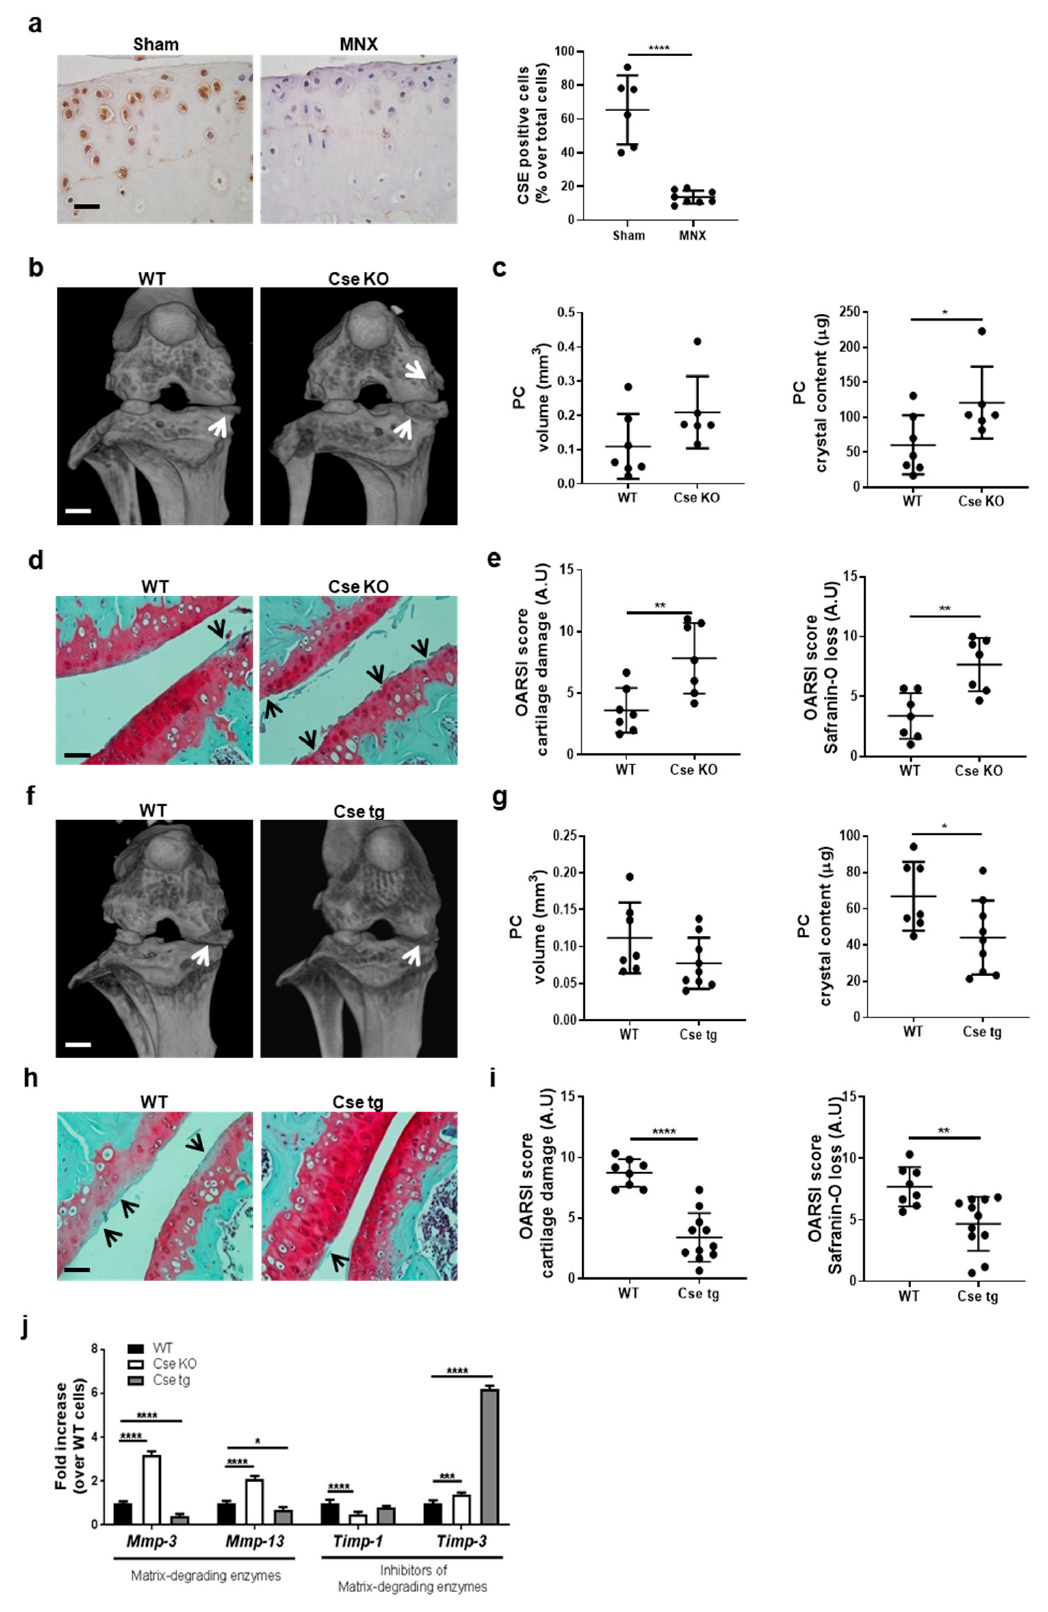
Figure 1. Cse deficiency exacerbates joint calcification and cartilage damage in an experimental model of knee PC. ( a ) Representative immunohistochemical analysis of Cse expression in knee sections from sham-operated and MNX WT mice. A knee section from a sham-operated Cse KO mouse was used to prove the specificity of the Cse antibody (data not shown). Scale bars 150 μ m. ( b ) Representative micro-CT scan images of WT and Cse KO murine knee joints two months after meniscectomy (MNX). White arrows show calcification in MNX WT knees and its exacerbation in Cse KO mice. Scale bars 1 mm. ( c ) Quantitative analysis of PC volume (mm 3 ) and PC crystal content ( μ g) in WT and Cse KO MNX knees. ( d )